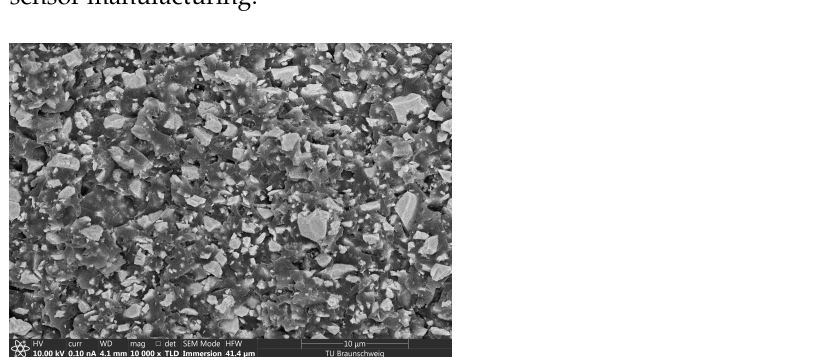
Figure 1. Scanning Electron Microscopy image of 20vol% PZT/photopolymer composite shows homogeneous particle dispersion and no